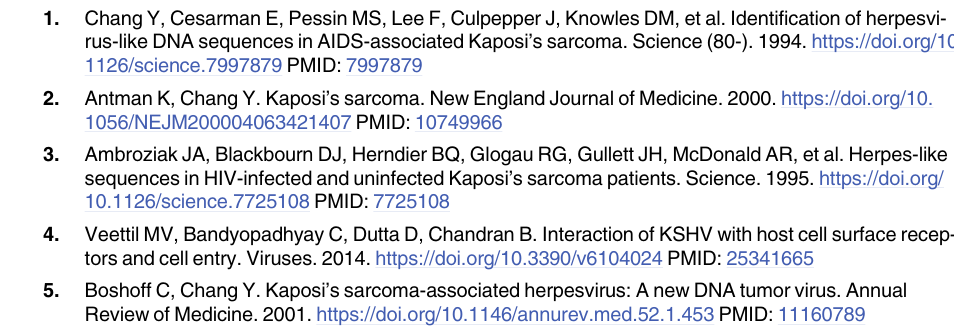
S1 Table. Primers used for qPCR assays in this